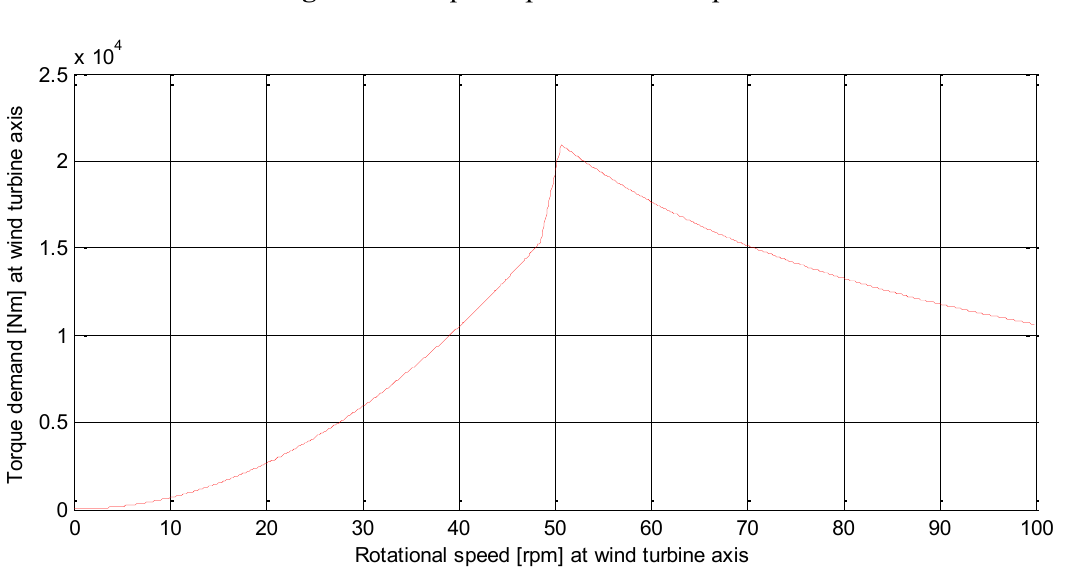
Figure 3. Torque setpoint vs. rotor